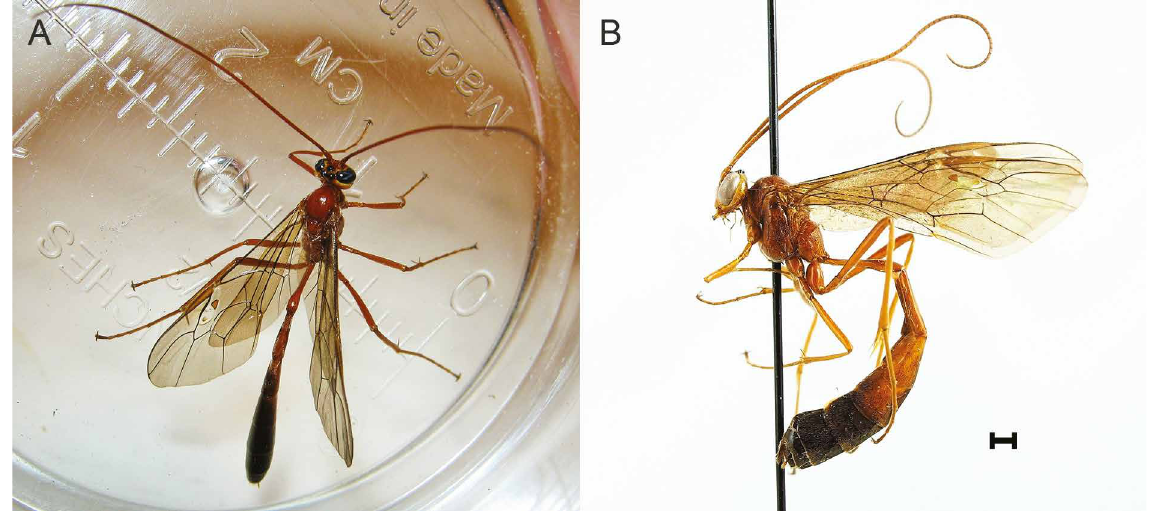
Fig. 2. Enicospilus cederbergi sp. nov., holotype, ♀ (NHRS-HEVA00008145). A . Habitus, dorsolateral view. B . Habitus, lateral view. Scale bar = 1